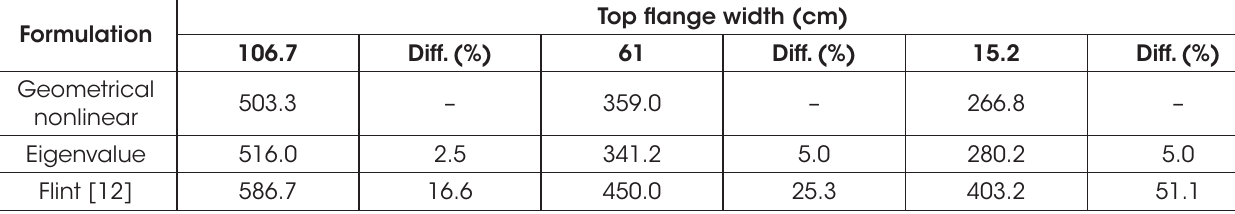
Comparison between numerical and analytical solutions of instability load Formulation